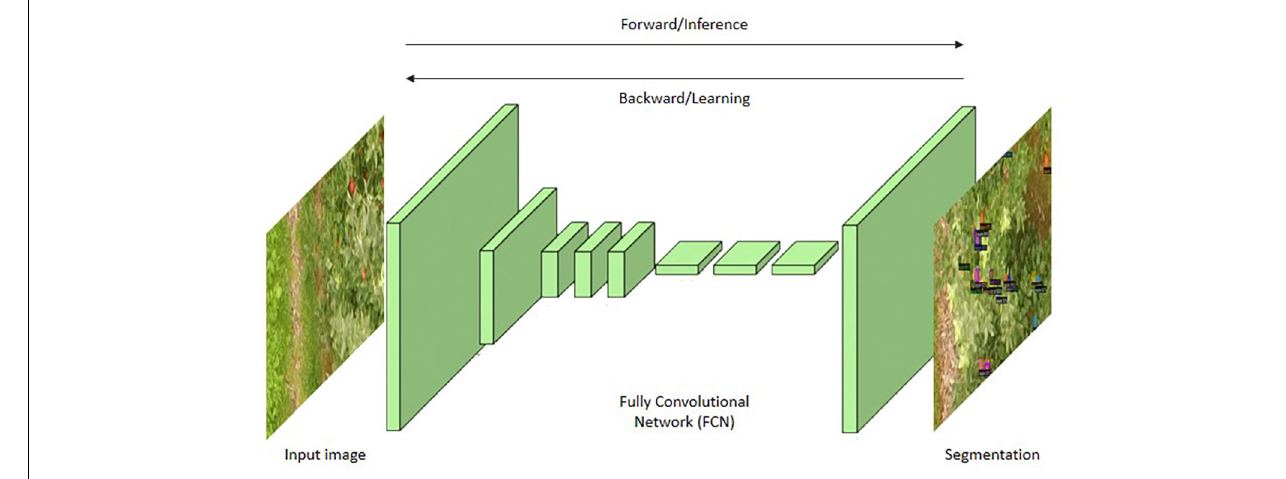
FIGURE 6 | Fully Convolutional Network (FCN).